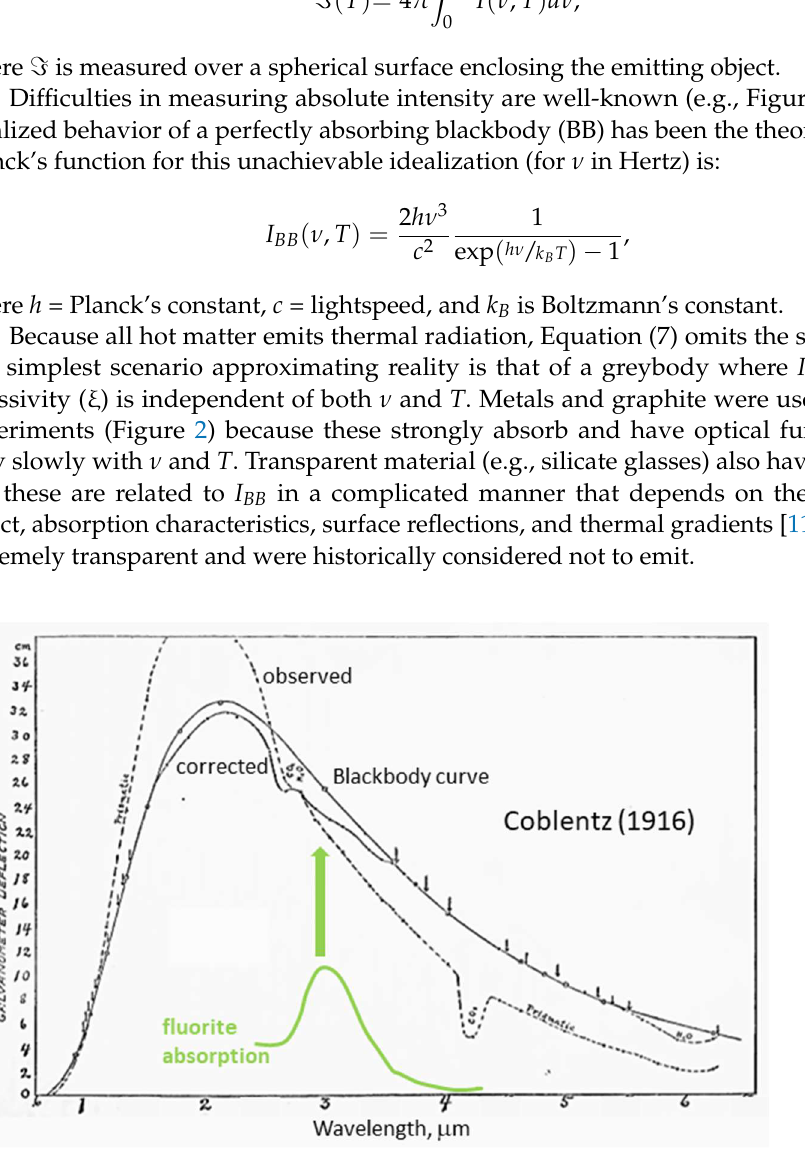
Figure 2. Emission curves of cavity radiation at 1370 K from Coblentz [12] compared to a near-IR absorption spectrum of natural fluorite (green curve, with an arbitrary y-scale). Dashed line = raw data, labeled “prismatic”. Solid curve with small dots = corrected data. Solid line with circles = the ideal Planck curve. Arrows indicate points Coblentz [12] used to fit the blackbody curve and determine the maximum. He omitted regions connected with atmospheric absorptions, in which features are partly due to use of natural fluorite as a prism, and in which material contains impurity bands.